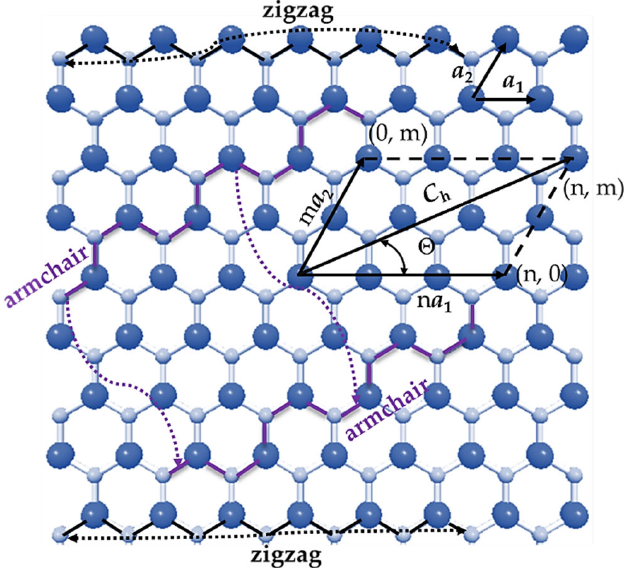
Figure 1. InN hexagonal sheet with definitions of the chiral vector, C h , and the chiral angle, Θ , as well as the scheme for rolling up in zigzag and armchair nanotubes. In atoms are depicted in bright blue; N atoms in pale blue.